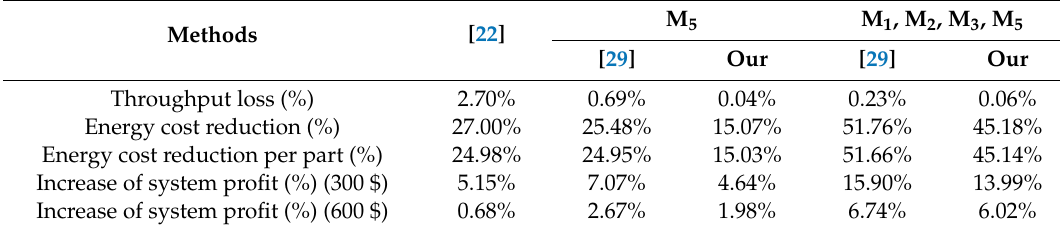
Table 7. System performance comparison of di ff erent methods.